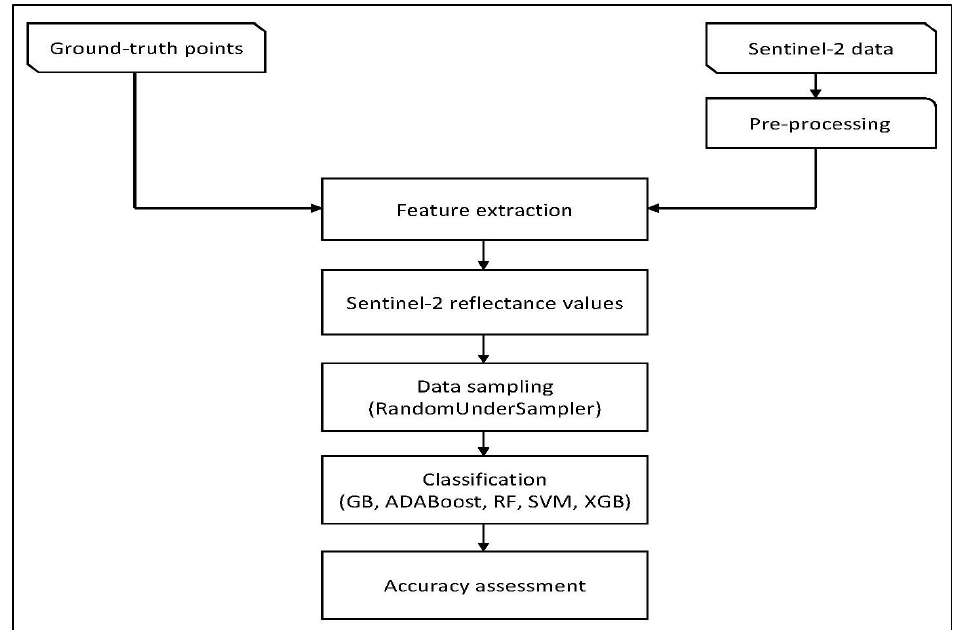
Figure 1 . Flowchart of the methodology developed in this research. Figure 1. Flowchart of the methodology developed in this research.